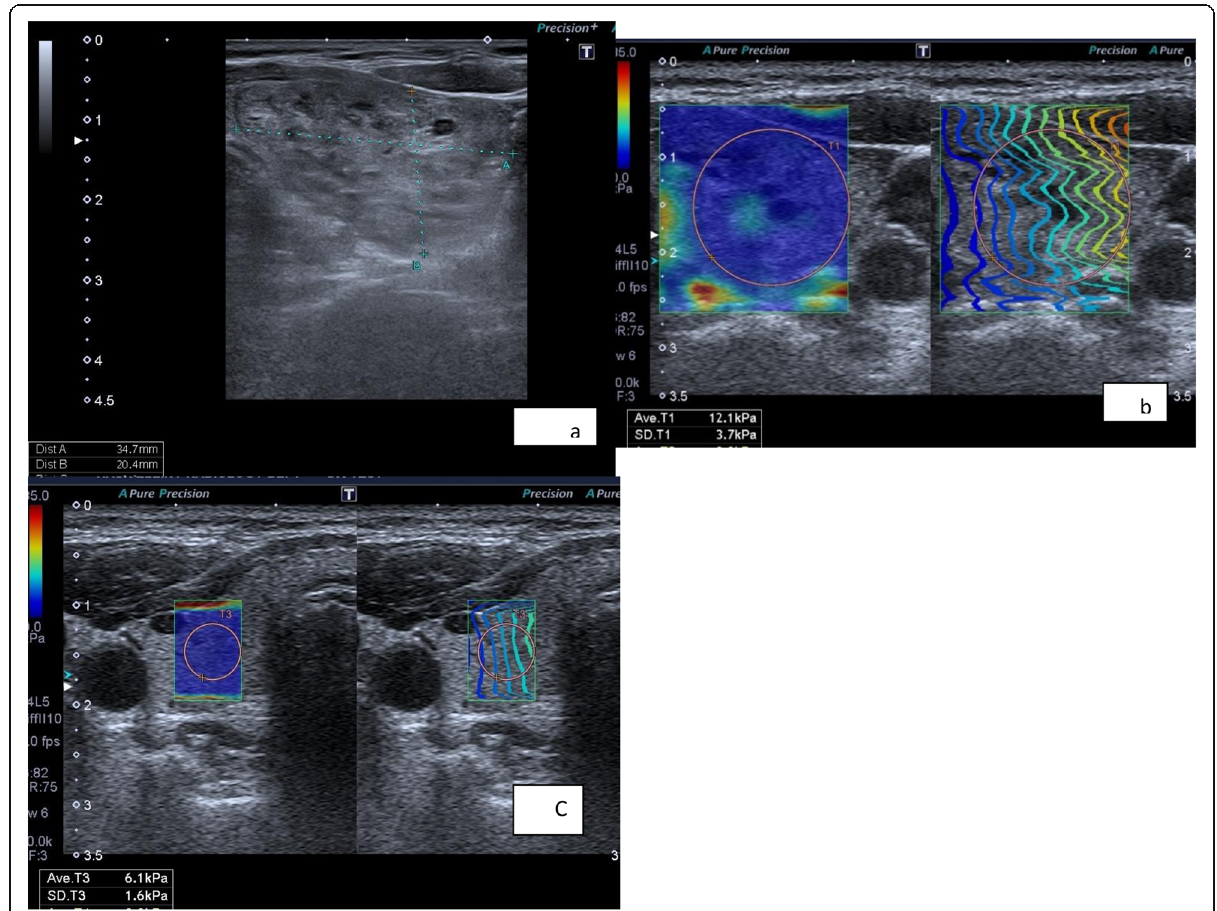
Fig. 2 Ultrasound images for a 39-year-old female patient who presented with a neck swelling. a Axial ultrasound B-mode image is showing a left thyroid isoechoic (solid) nodule with flecks of calcification (arrow) (TI-RADS 4). b Axial SWE of the thyroid nodule ( E mean = 18.1 kPa and ER = 1.02). c Axial SWE of the normal right thyroid parenchyma; the FNAC and the post-hemithyroidectomy histopathology revealed a colloid nodular hyperplasia (Bethesda 2); thus, in this case, SWE EIs were considered congruent with the cytological examination as being negative for